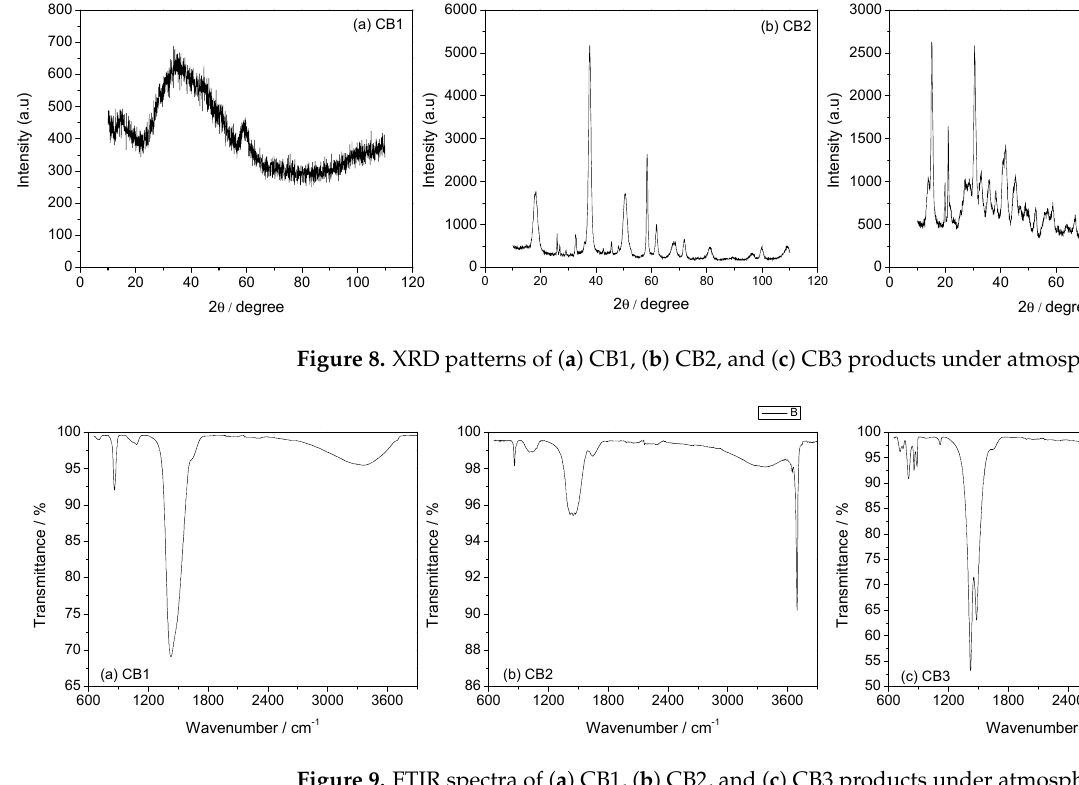
were characterized by FTIR, XRD, and TGA.